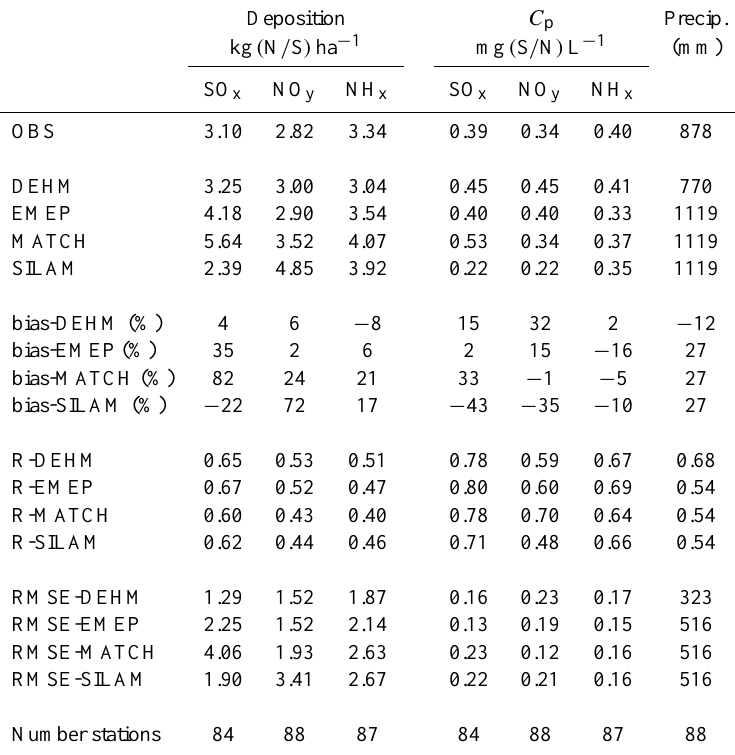
Table 4. Evaluation of modelled wet deposition, concentration in precipitation ( C p ) and precipitation using observations from the EMEP measurement network for the years